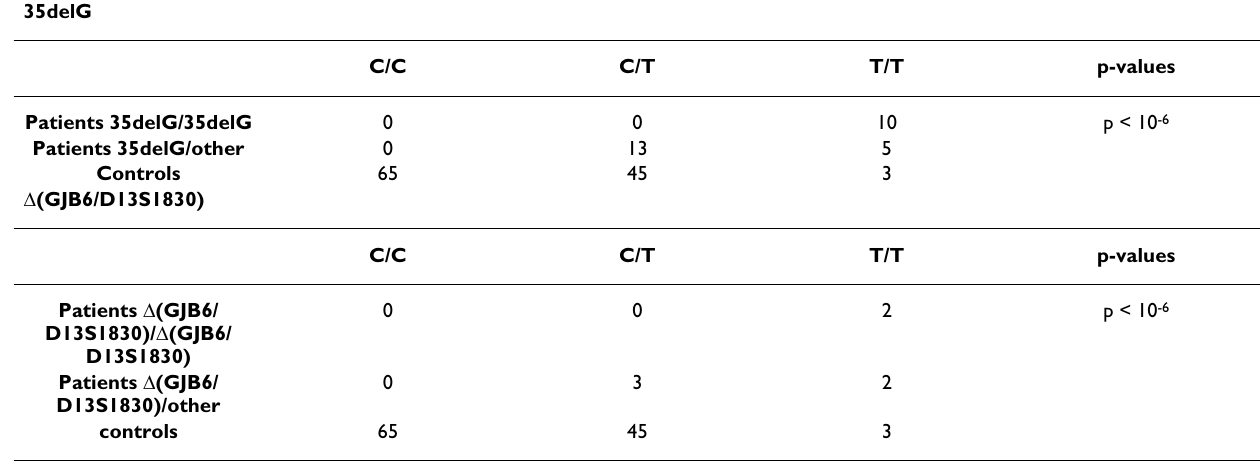
Table 3: Distribution of the C765T polymorphism among patients 35delG